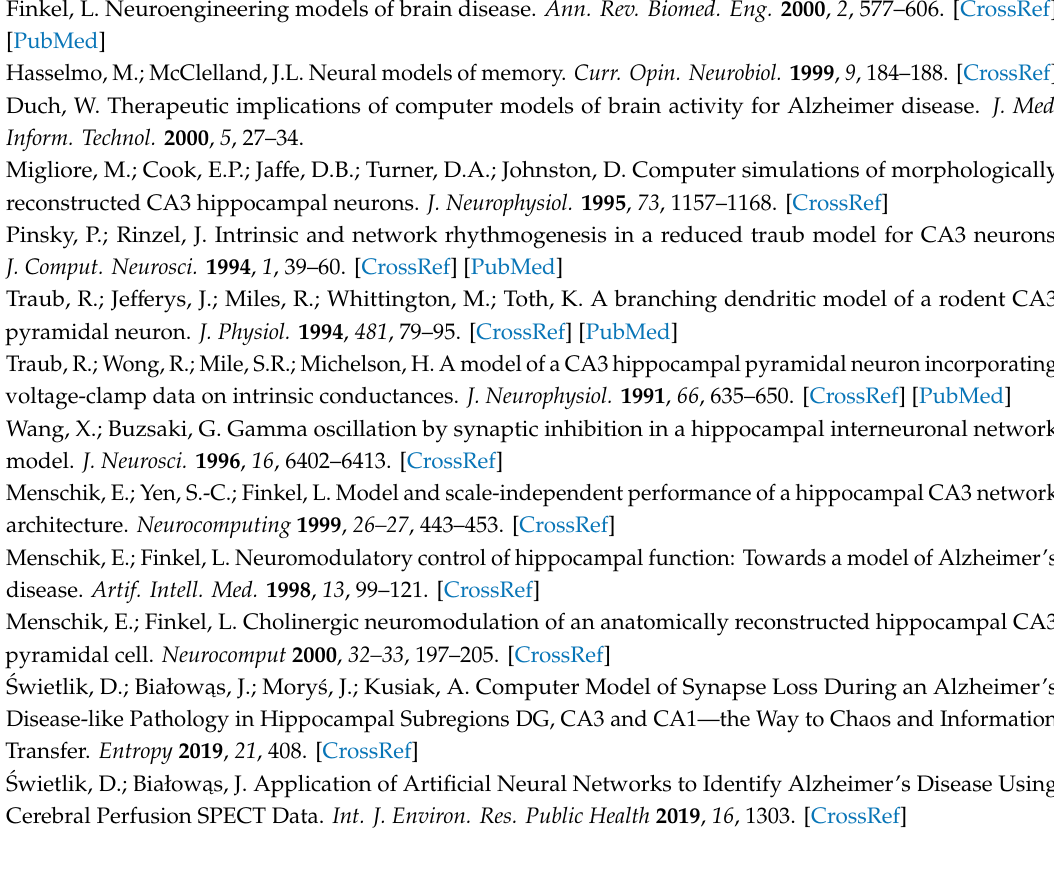
Supplementary Materials: Video AD: CA3-CA1 network simulation of Alzheimer disease-pathology model, Video healthy-control model: CA3-CA1 network simulation of